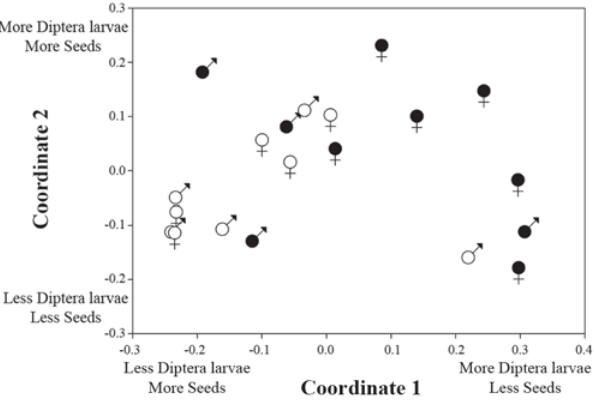
Fig. 3. Non-Metric Multi-Dimensional Scaling Ordination (NMDS) of monthly variations of the diet with respect to sex. Stress = 0.10. Filled symbols are the dry months.